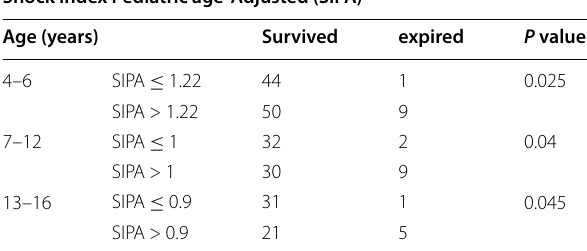
Table 5 Age wise distribution of SIPA with results of chi-square